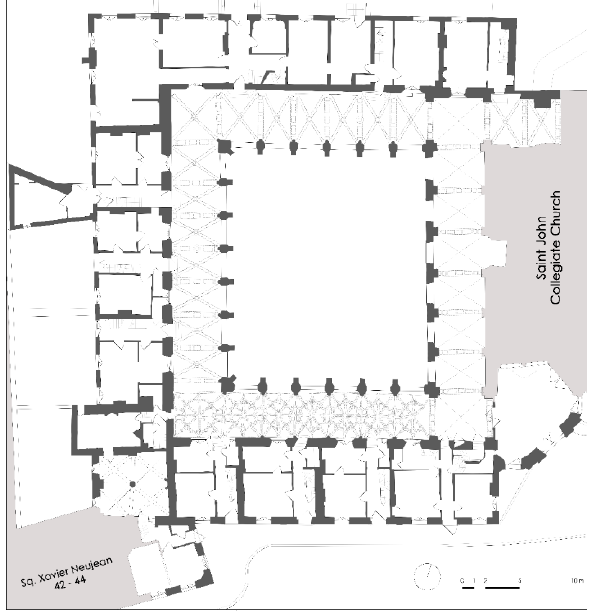
Figure 8. Floor plan of the cloister, ground floor (graphic scale). This document is based on a survey achieved in 2014 by GEOCAD.